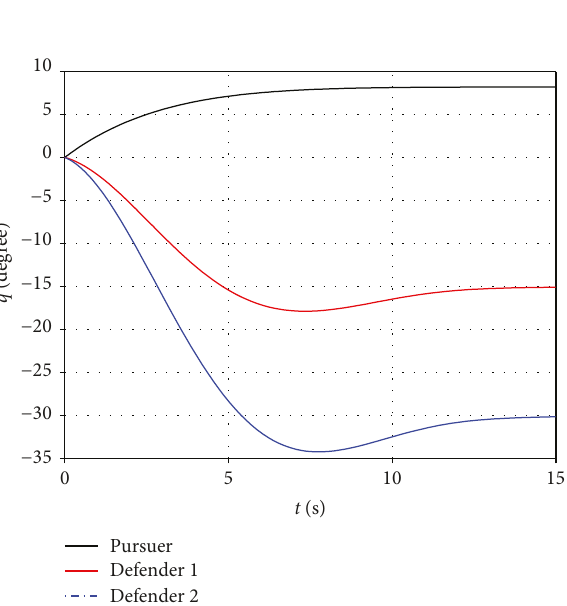
Figure 4: Intercept angle variation of the